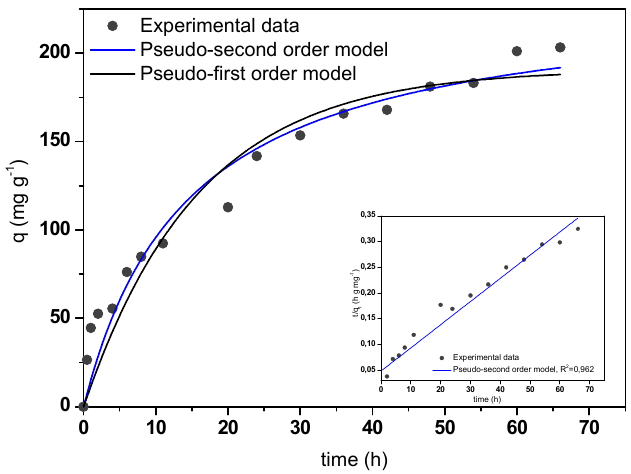
Figure 7. Experimental and theoretical kinetic curve of MB adsorption onto A/ γ -Fe 2 O 3 /f-CNT beads.